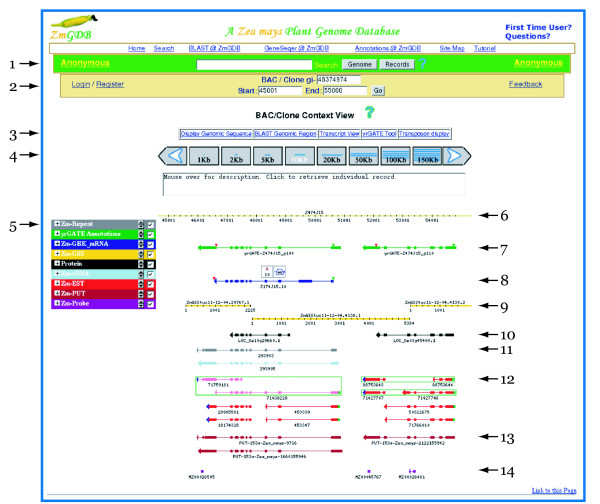
A ZmGDB context page focused on a Zea mays BAC assembly (accession Z474J15; GenBank id 48374974). A site header contains site navigation and search controls (items 1 and 2). Links to integrated webservices (item 3) and context navigation controls (item 4) are available. The feature control panel (item 5) and context graphic shows yrGATE community annotations (item 7), GenBank gene features (item 8), PlantGDB GSS assemblies (item 9), rice predicted protein alignments (item 10), cDNA alignments (item 11), EST alignments (item 12), PlantGDB Unique Transcript alignments (item 13), and MaizeArray microarray probe alignments (item 14) in the genomic region spanning bases 45,001 to 55,000 (item 6) of the assembled sequence. Exon features are displayed as filled rectangles connected by intronic features represented by similarly colored lines. Predicted start and stop codons of open reading frames are represented by green and red triangles, respectively. Arrowheads represent genomic strand orientation when this can be determined. Noncognate features are represented by alternative feature colors (pink for EST and grey for cDNA features). BAC, bacterial artificial chromosome; EST, expressed sequence tag; GSS, genome survey sequence.